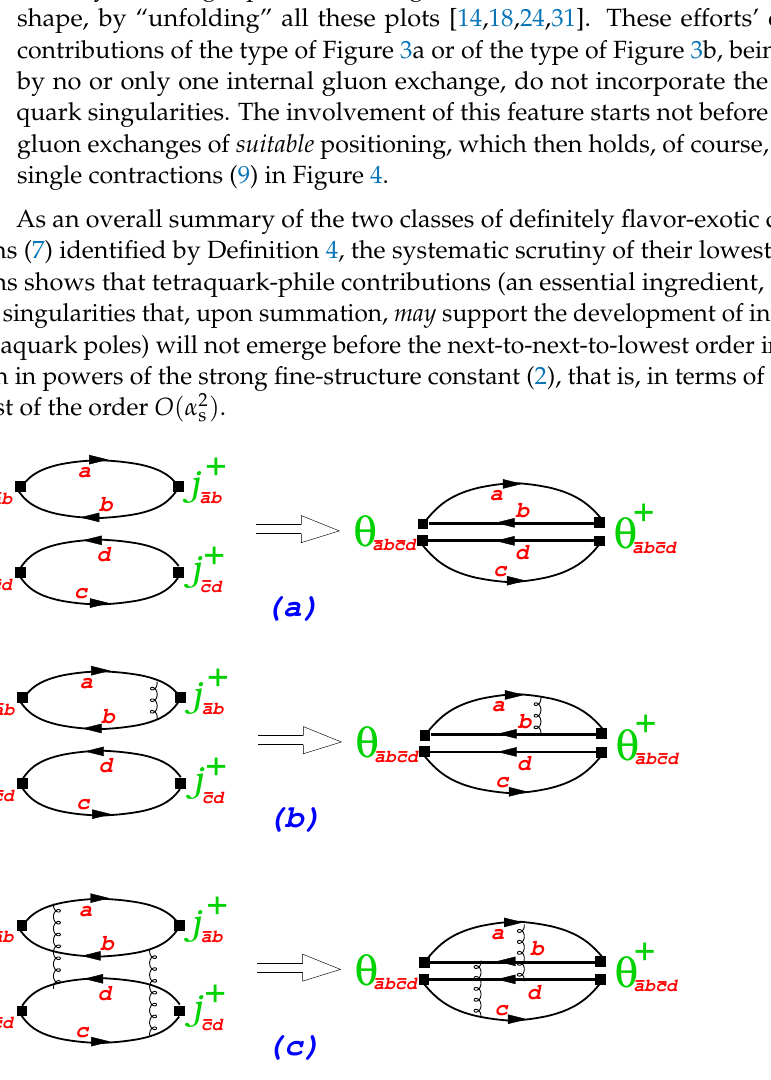
Figure 1. Definitely flavor-exotic four-current correlation function (7) of flavor-preserving type ( left ) and ( right ) its contraction (8) to two-point correlation function of tetraquark interpolating opera- tors (6) [30,32]. Representative contributions of lowest perturbative orders: ( a ) O ( α 0 s ) , ( b ) O ( α s ) and ( c ) O ( α 2 s )